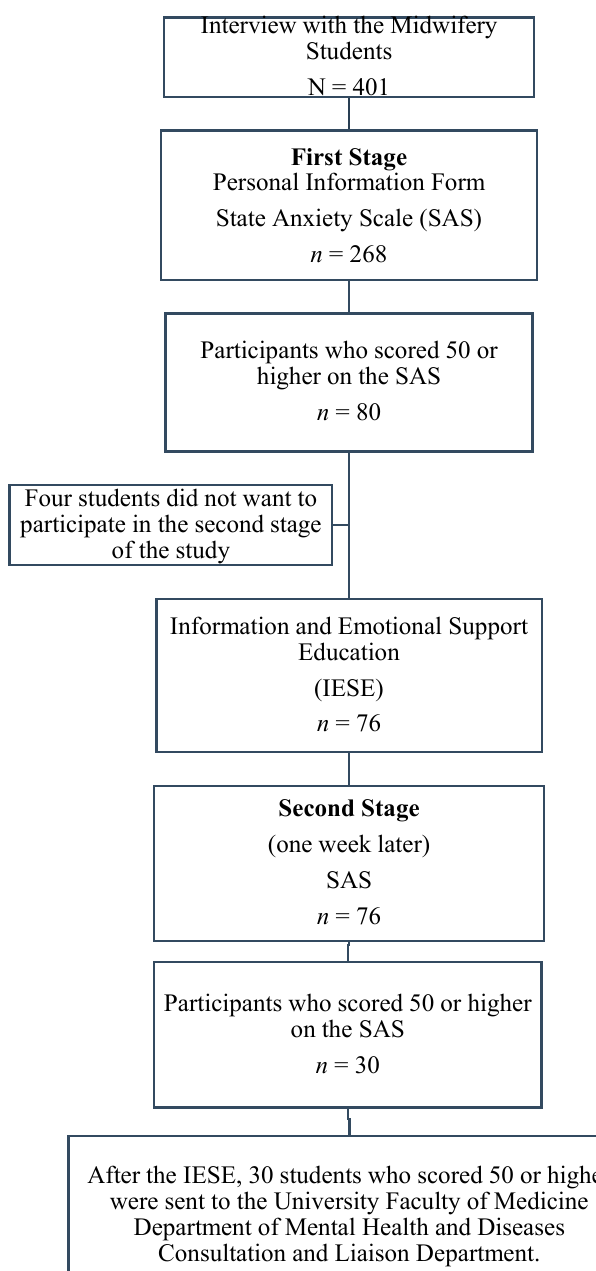
Figure 1. Flow chart of data collection.